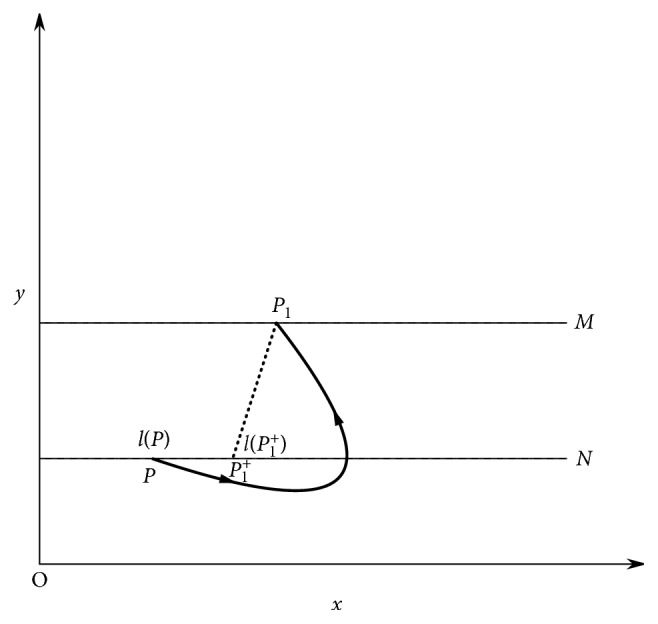
Successor function.